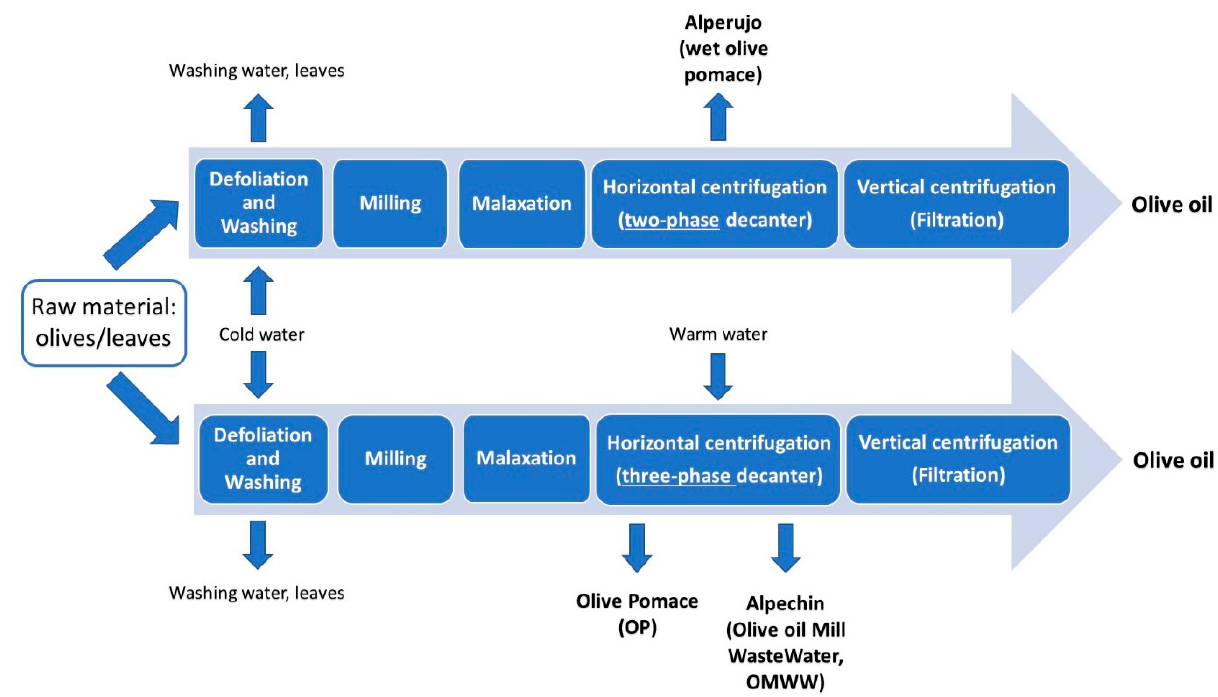
Figure 1. Layout of the main steps of olive oil production involving two- or three-phase horizontal centrifugation and the main by-products obtained.